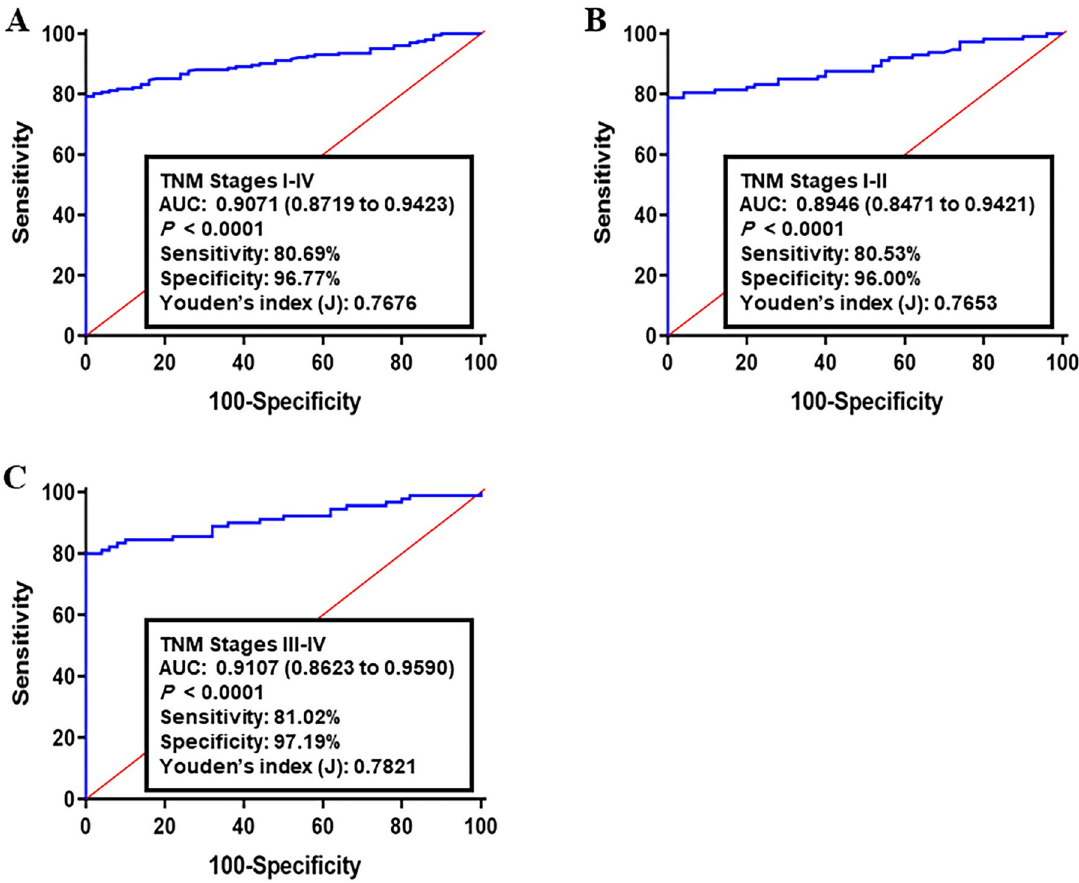
Fig 3. Receiver operating characteristics (ROC) curve analysis of the log it model with the ACOT8/ACSL5/FASN/HMGBCS2/ SCD1 panel in validation set II. The study group consisted of 203 CRC tumor specimens and 50 normal tissues. Using the optimal cutoff value as 0.493, the diagnostic performance of gene panel for discriminating (A) All TNM stages, (B) early CRC (I-II TNM stages, n = 113), and (C) advanced CRC (III-IV TNM stages, n = 90) from healthy samples was examined. Log it (p) of model was 0.429 + 0.659 x ACOT8 + 0.084 x ACSL5 + 0.029 x FASN + 0.201 x HMGCS2 + 0.119 x SCD1.